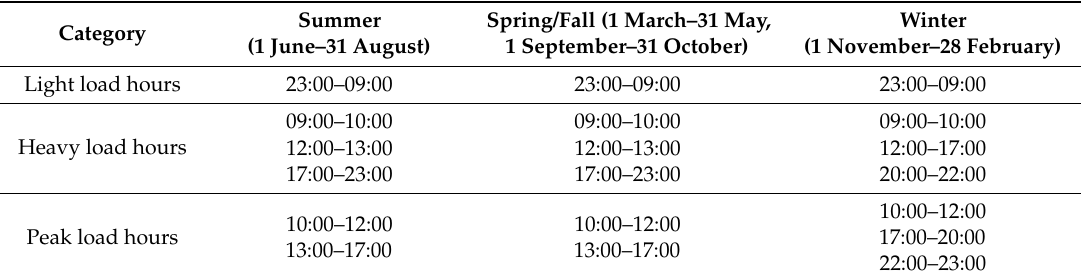
Table 1. EV charging structure in Korea.